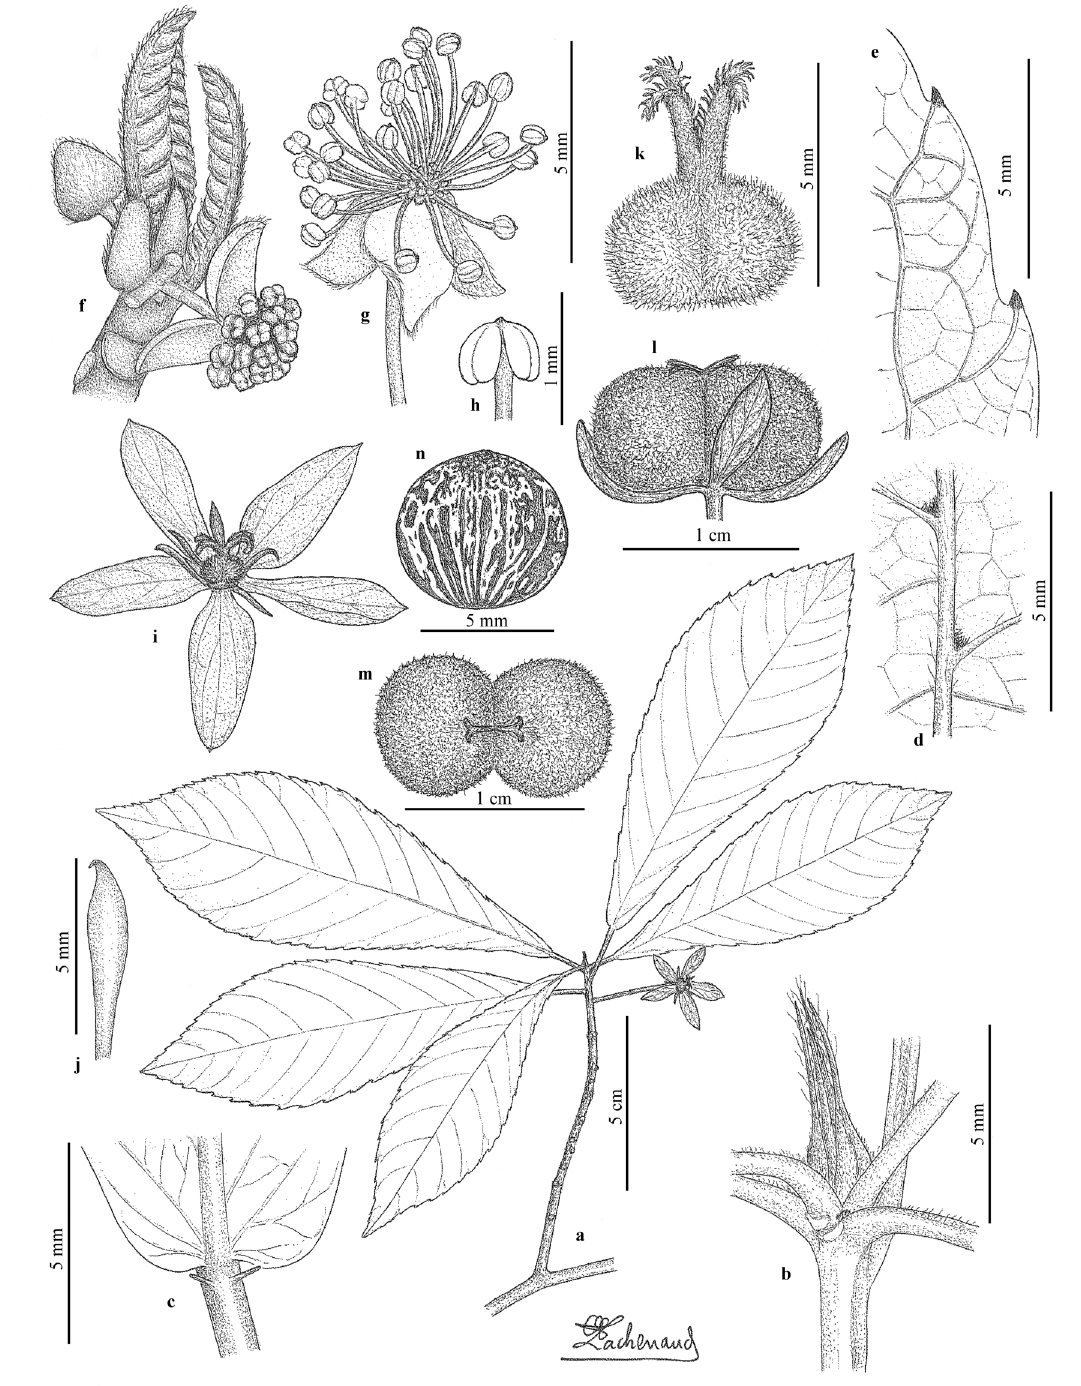
Fig. 3. Illustration of Paranecepsia andrafiabensis Barberá & O.Lachenaud sp. nov. a . Branch with pistillate flower. b . Bud. c . Leaf base with stipels. d . Detail of the lower leaf surface with domatia. e . Leaf margin. f . Staminate inflorescence. g . Staminate flower. h . Stamen. i . Pistillate flower. j . Petal of pistillate flower. k . Ovary and stigmas, lateral view. l . Fruit with persistent calyx, lateral view. m . Fruit, top view. n . Seed, lateral view. From Barberá et al. 2797 (a–b), Capuron SF-28711 (c–e, l–n), Barberá 2799 (f), Barberá et al. 2765 (g–h), Barberá et al. 2771 (i), Barberá et al. 2798 (j), Barberá et al. 2764 (k). Drawn by